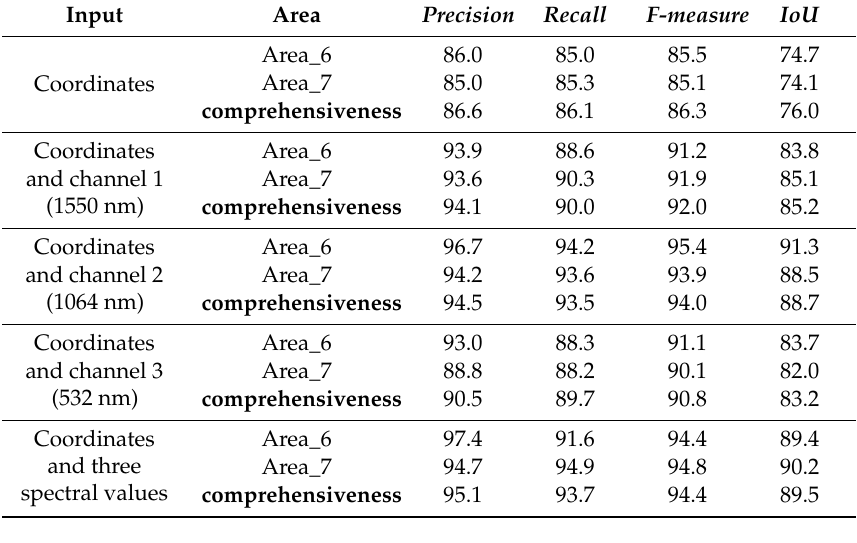
Table 3. A comparison between training with the di ff erent input feature.